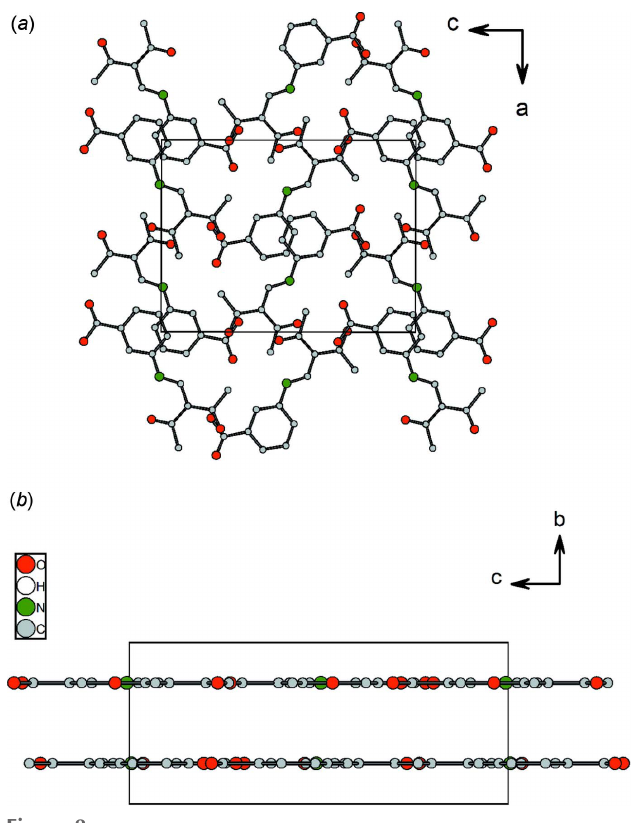
Figure 8 Molecular packing of 2 in the crystal, ( a ) in a view along the b axis and ( b ) in a view along the a axis.